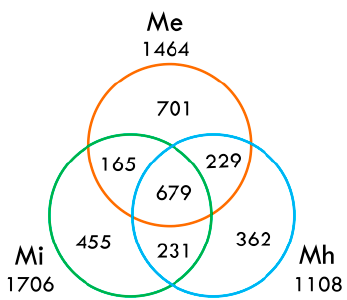
Figure 5. Venn diagram on shared and unique ortholog families of secreted proteins in three Meloidogyne species. The numbers in the Venn diagram indicate the ortholog families of secreted proteins. The numbers outside the Venn diagram show the total number of predicted secreted proteins for each Meloidogyne species. Me: M. enterolobii ; Mi: M. incognita ; Mh: M. hapla .